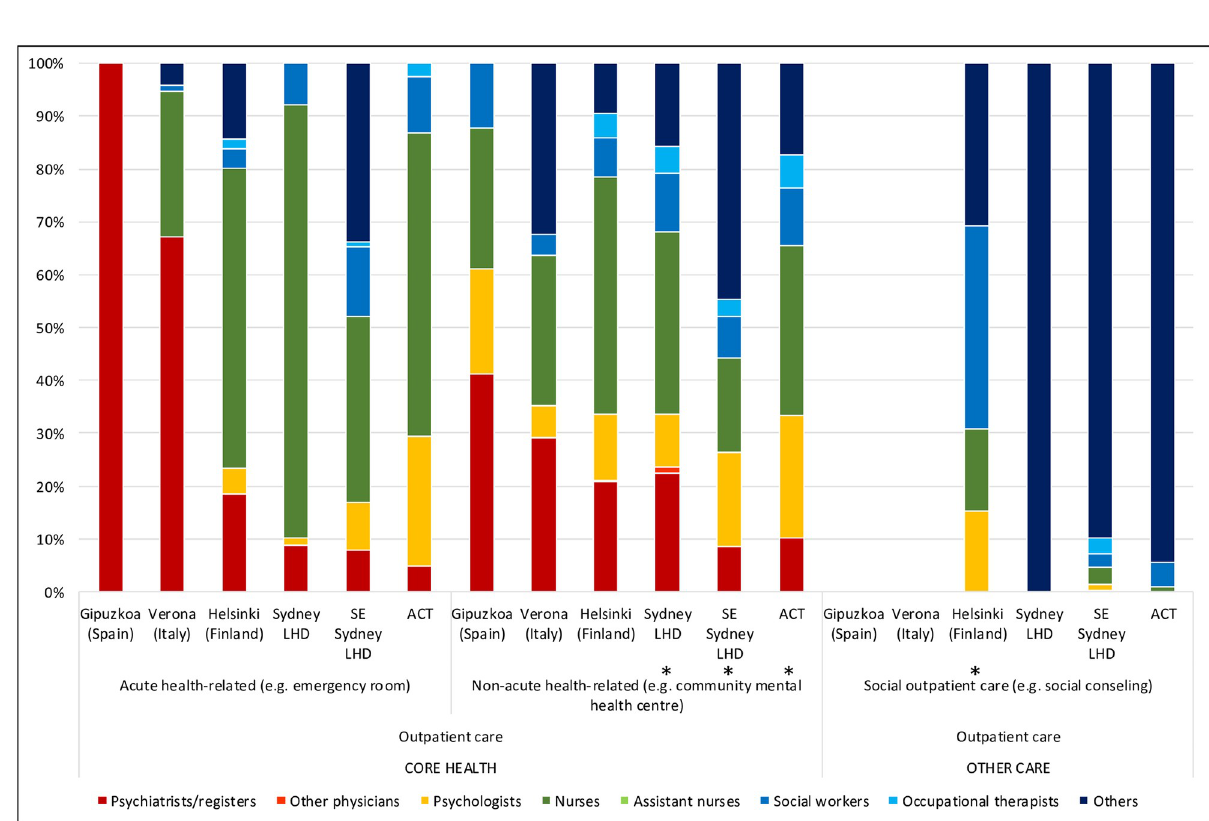
Fig 5. Percentage distribution of workforce in adult mental health services for outpatient care in the six study areas. � Missing data.